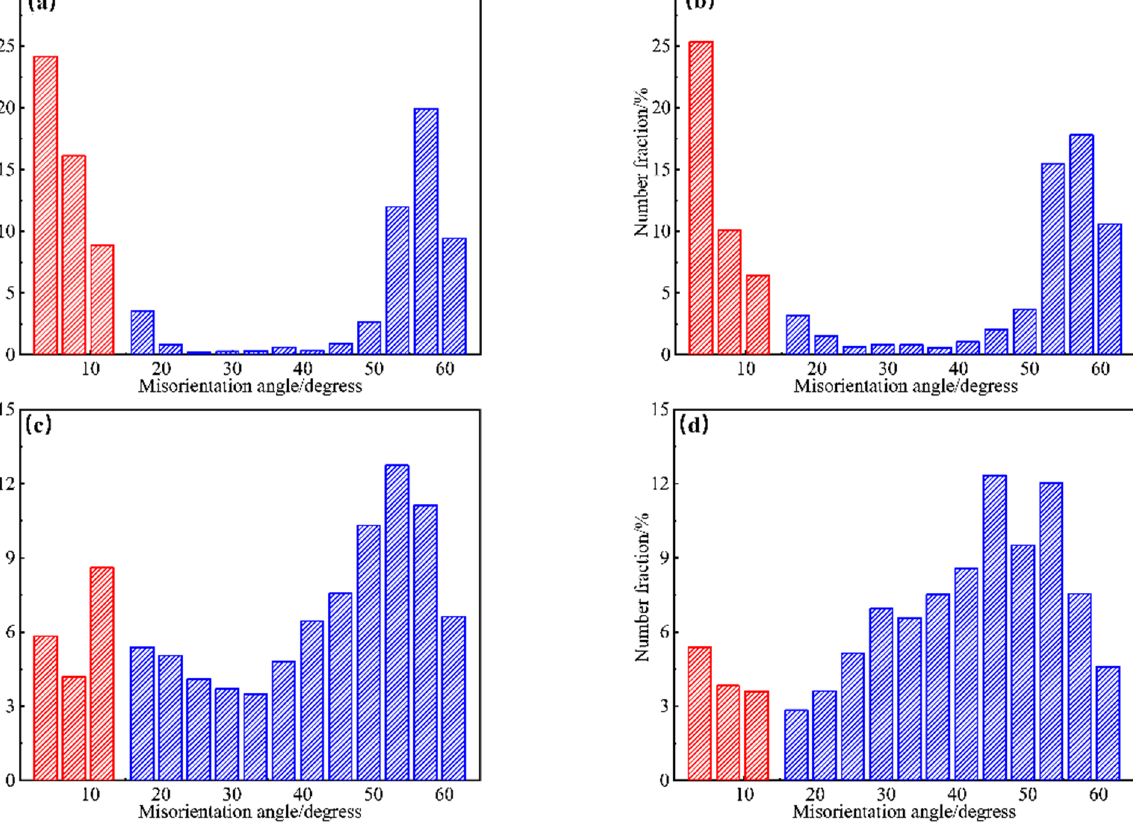
Figure 10. Results of small and large angle grain boundaries proportion. ( a ) WS; ( b ) CGZ; ( c ) FGZ; ( d ) BM.